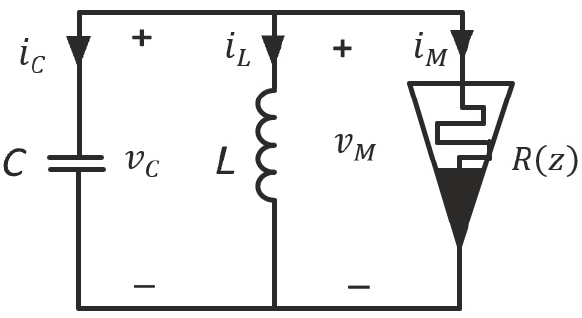
Figure 7. Simple fractional-order memristive chaotic circuit.